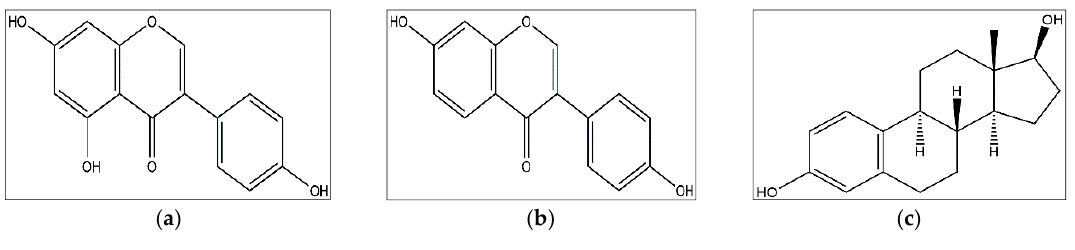
Figure 2. Structures of genistein ( a ); daidzein ( b ); 17- β -estradiol ( c ).